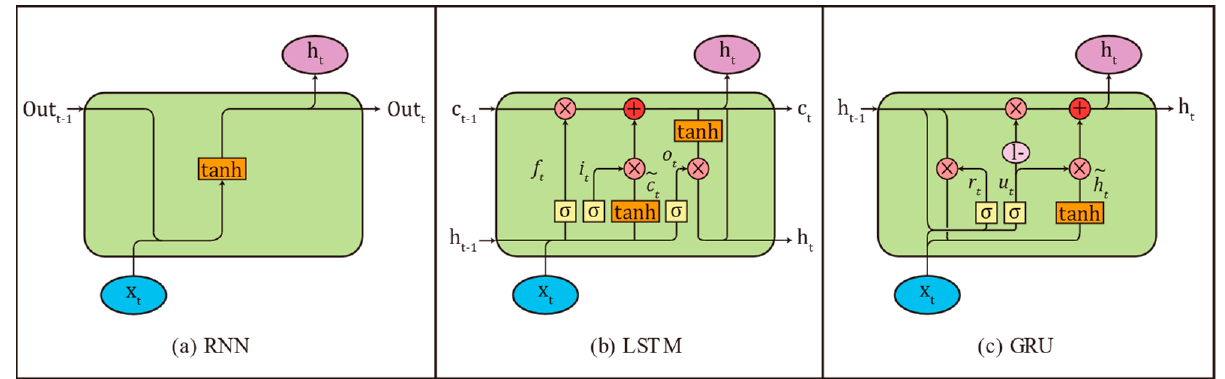
Figure 4. Internal structure of RNN, LSTM, and GRU.